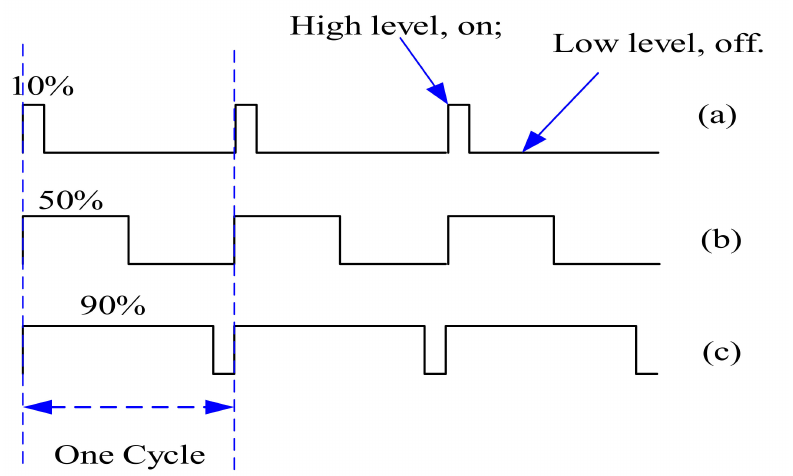
Figure 5. The technology of PWM. ( a ) the duty cycle is 10%; ( b ) the duty cycle is 50%; ( c ) the duty cycle is